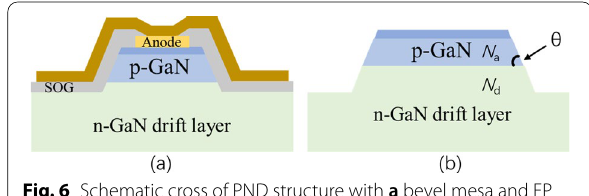
Fig. 6 Schematic cross of PND structure with a bevel mesa and FP structure, b PND epitaxial structure is simulated by treating N A , N D and θ as variable [76,